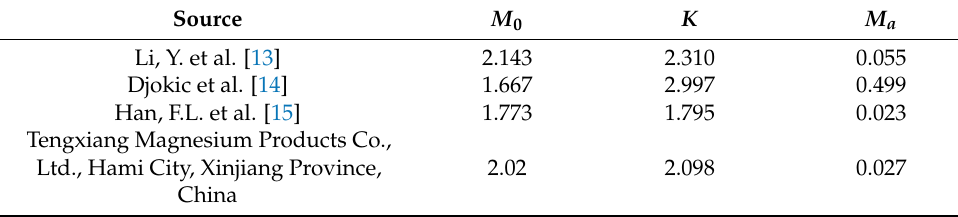
Table 1. Activity evaluation index of MS based on chemical